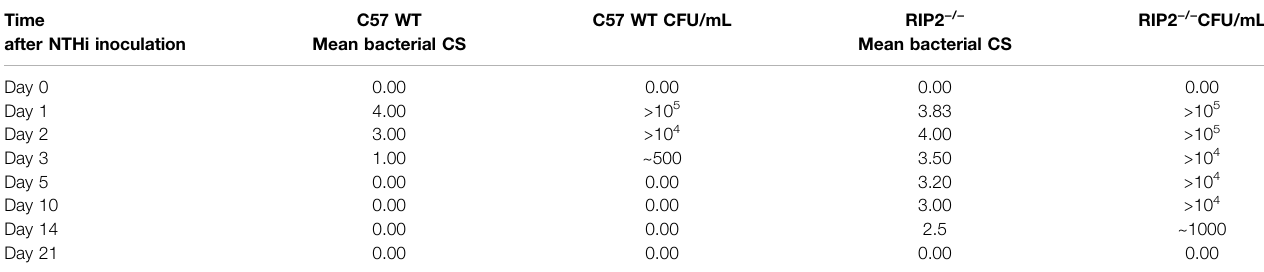
TABLE 1 | Impaired bacterial clearance of RIP2 − / − MEs. No colony forming units (CFUs) were detected by day 5 after NTHi inoculation in C57BL/6 mice. Bacterial clearance was impaired in RIP2 − / − mice until 21 days after inoculation. NTHi was isolated from more than half of the MEs by 14 days. Mean bacterial colonization of the culture positiveplates wasevaluatedusing semi-quantitativeanalysisofbacterialcolonizationscore(CS):0indicatednoCFUs, 1indicates onequadrant withCFUs, 2indicates two quadrants with CFUs, 3 indicates three quadrants with CFUs and 4 indicates four quadrants with CFUs. Data represent positive culture plates out of 6 MEs. Time C57 WT after NTHi inoculation Mean bacterial